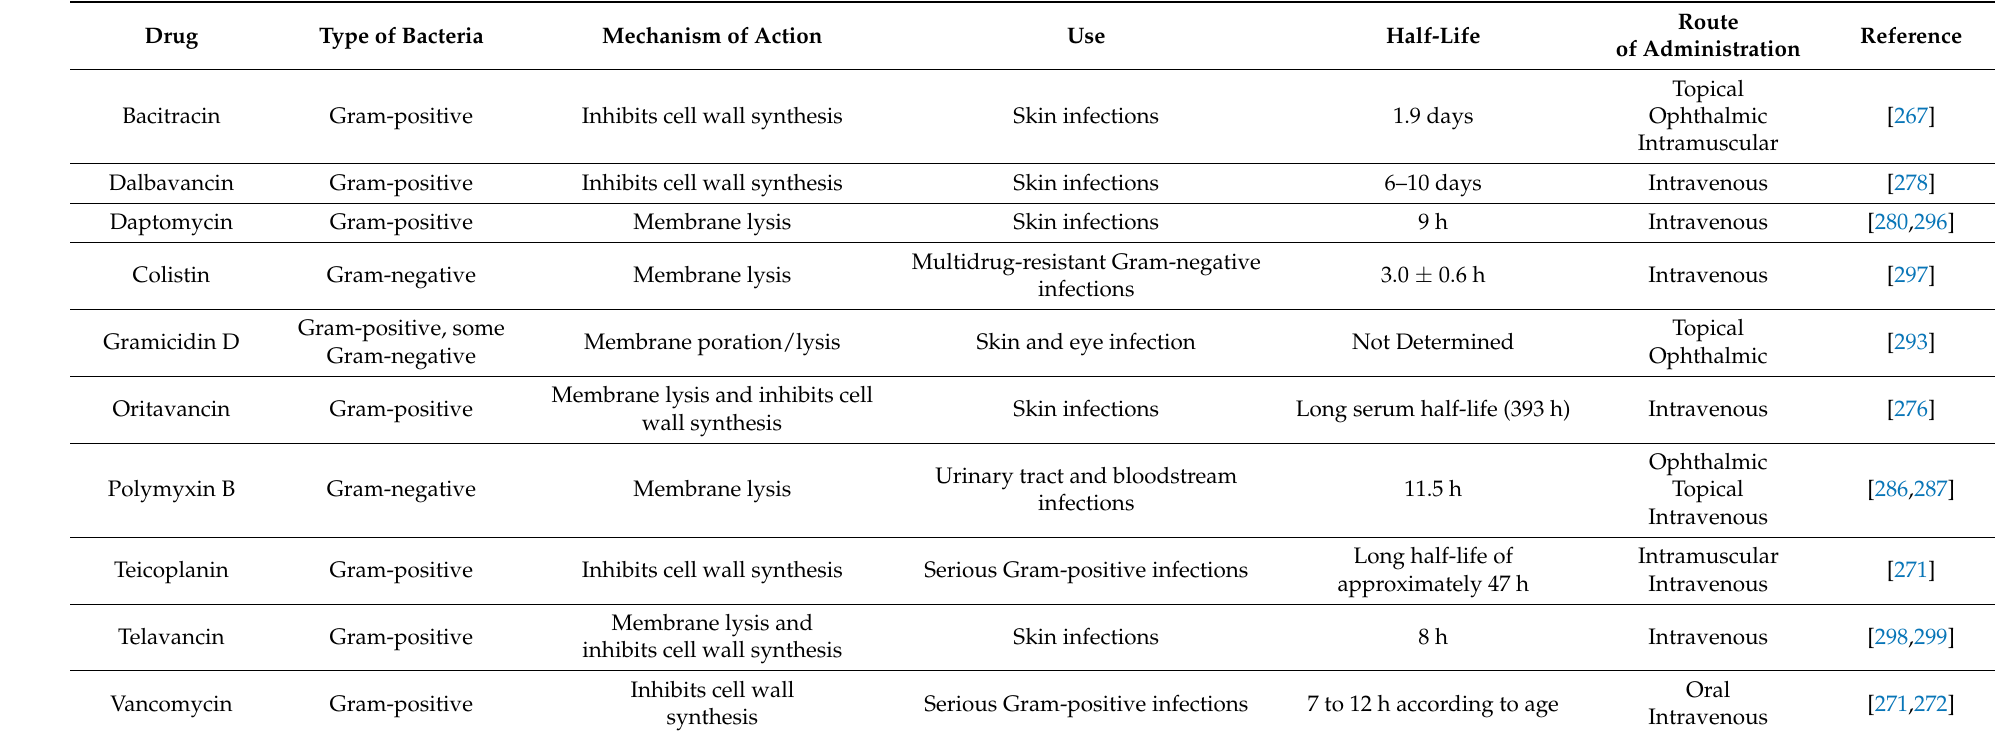
Table 2. Summary of antibacterial peptides in the